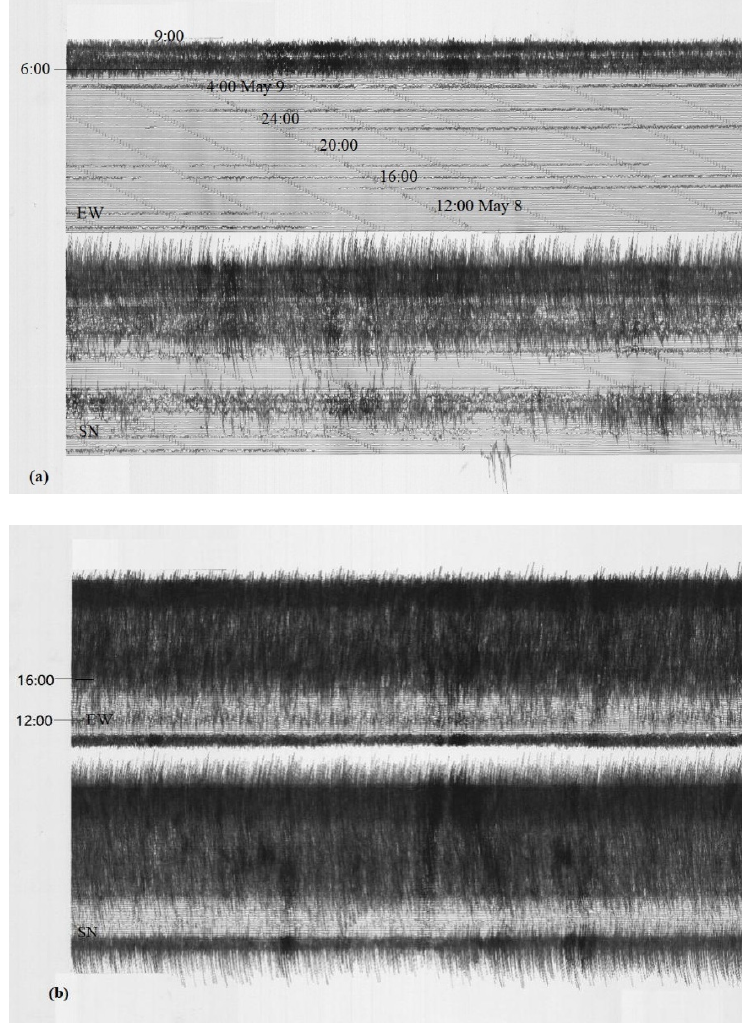
Figure 5. Copies of part of the original real-time analog recordings: ( a ) from 0900 on 8 May to 0900 on 9 May and ( b ) from 0900 on 9 May to 0900 on 10 May in 2008 at the GBD station.